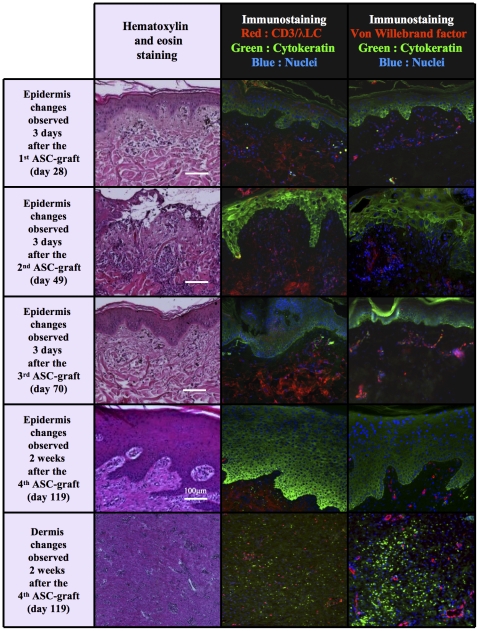
After local irradiation ASCs favoured reepithelialisation and enhanced lymphocyte infiltration and angiogenesis in dermis.Kinetic study from four iterative biopsies performed few days after each ASC-graft in representative animals (magnification in the original ×100). Early cleaning of damaged epidermis was followed by complete epidermis recovery/hyperproliferative keratinocyte activity. Two weeks after the 4th ASC-graft, early T and B lymphocyte infiltration in dermis near the subcutis, with a strong increase in vascularisation.